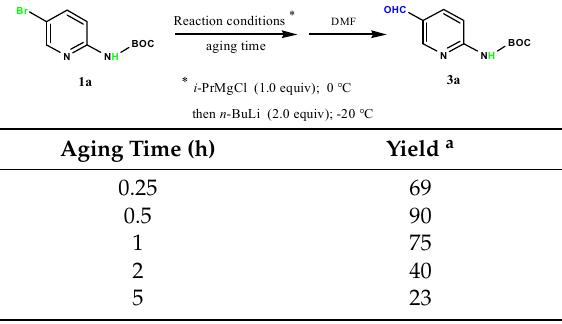
Table 2. Stability of metalating reagents prepared from 2-( N -BOC-amino)-5-bromopyridine.